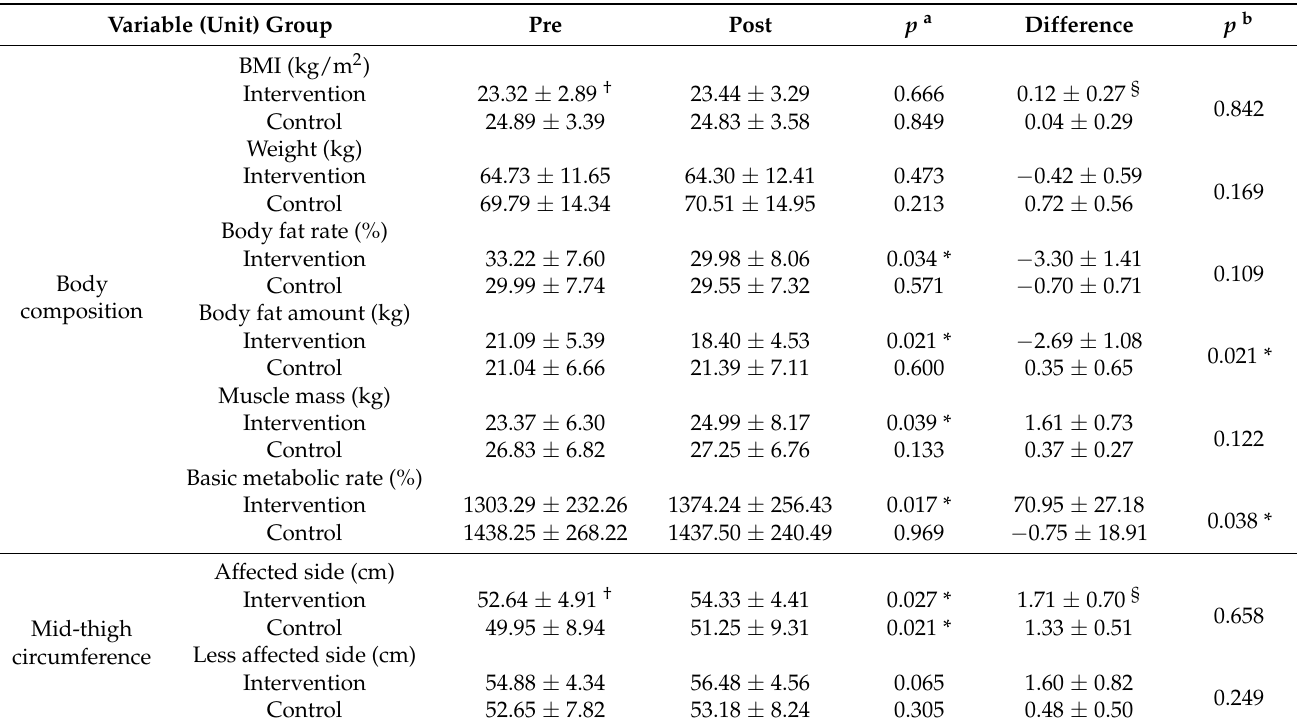
Table 4. Changes in body